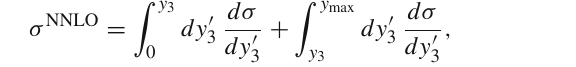
Fig. 2 Illustration of a configuration of particles that renders SD flavourwithJ ADE reclusteringIRCunsafeatNNNLO.Thejetboundary is illustrated in the dashed oval, with the hard quark Q and hard gluon g with the largest pairwise mass and pass SD. An arbitrarily soft quark q lands in the jet and is therefore never groomed away, rendering the jet flavour